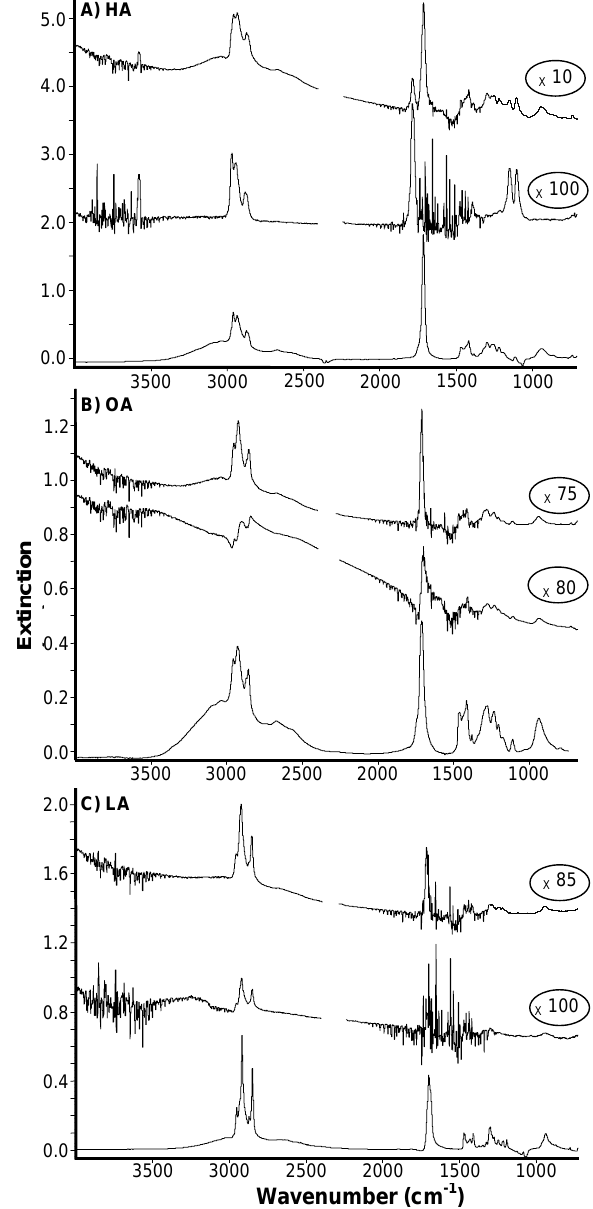
Figure 3. Infrared extinction spectra of HA (a) , OA (b) and LA (c) in different conditions: bottom spectra are from bulk phase acid; medium spectra corresponds to homogeneously nucleated acid par- ticles; upper spectra are from heterogeneously nucleated acids onto NaCl particles. In all cases, the upper spectra have been increased for clarity (increasing factor: ×